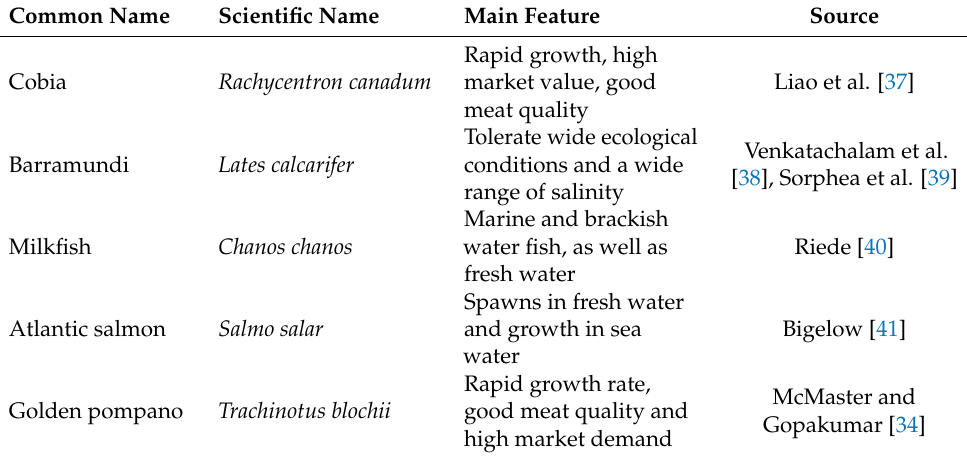
Table 4. The species of marine or coastal fish, highlighting their main characteristics, as covered in this